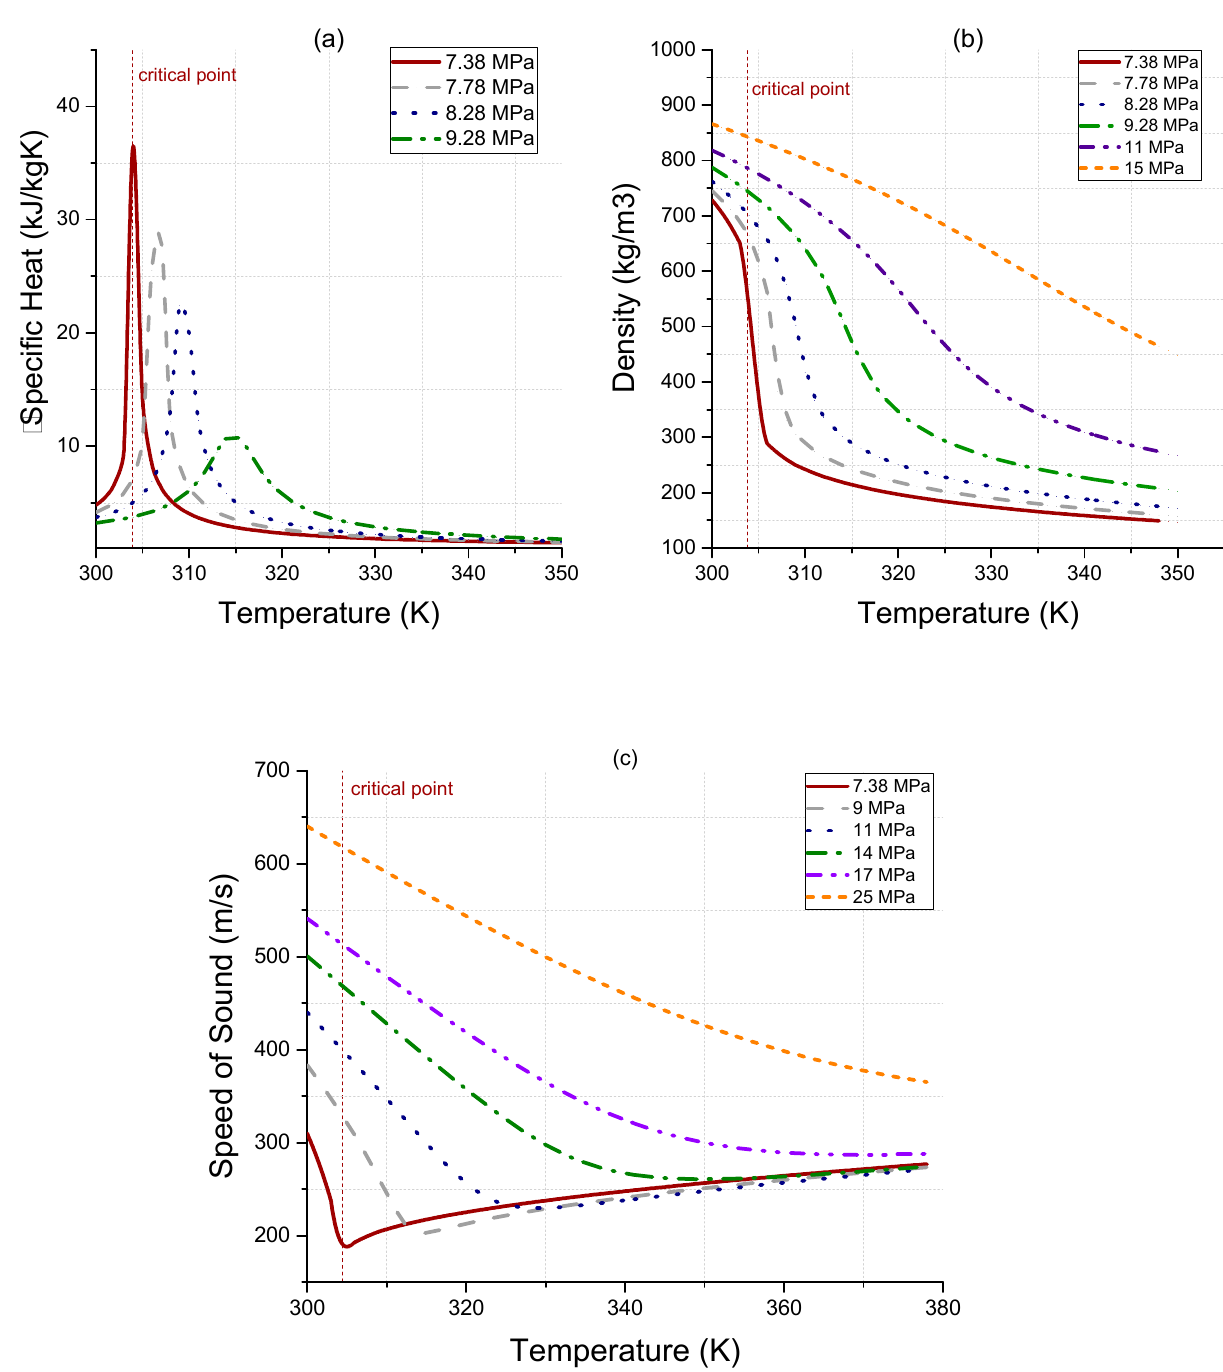
Figure 1. Carbon dioxide’s ( a ) specific heat, ( b ) density, and ( c ) speed of sound as a function of temperature .